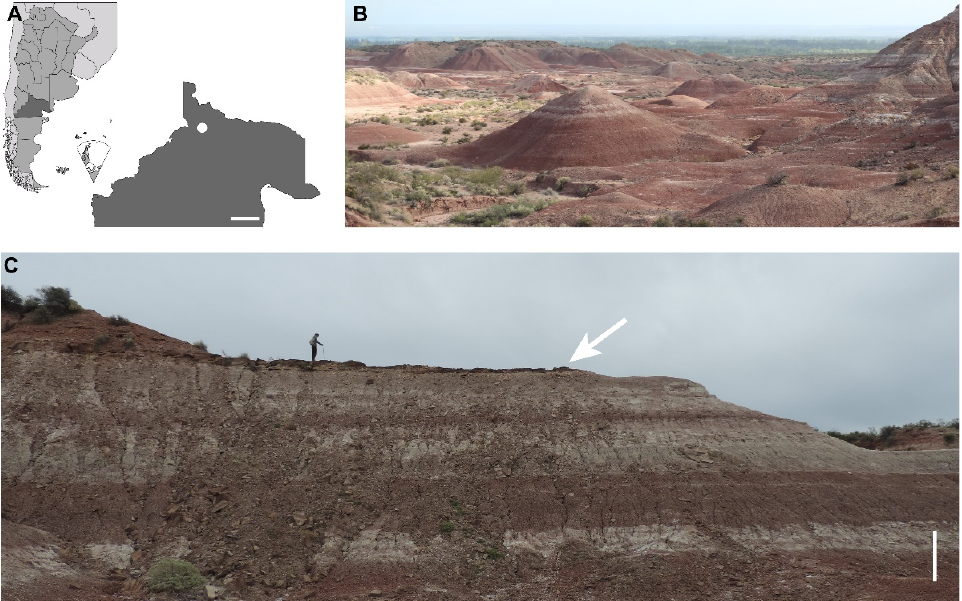
Figure 1. The new ichnological locality in the Área Natural Protegida Municipal Paso Córdoba, General Roca, Río Negro Province, Argentina. ( A ) Geographical map of the location of the site within the Río Negro province silhouette; the white dot indicates the General Roca area. Scale bar equals to 100 km; ( B ) Panoramic photography of Valle de la Luna Rojo, where the Anacleto Formation crops out; ( C ) Panoramic view of the Cañadón del Surgente (Anacleto Formation), where the site was found (white arrow). From the base, purple and reddish pelites alternate with whitish calcareous beds, above which fluvial red beds overlay. The arrow indicates the location of the ichnological material in a medium- to fine-grained sandstone bed. Scale bar equals 2 m.